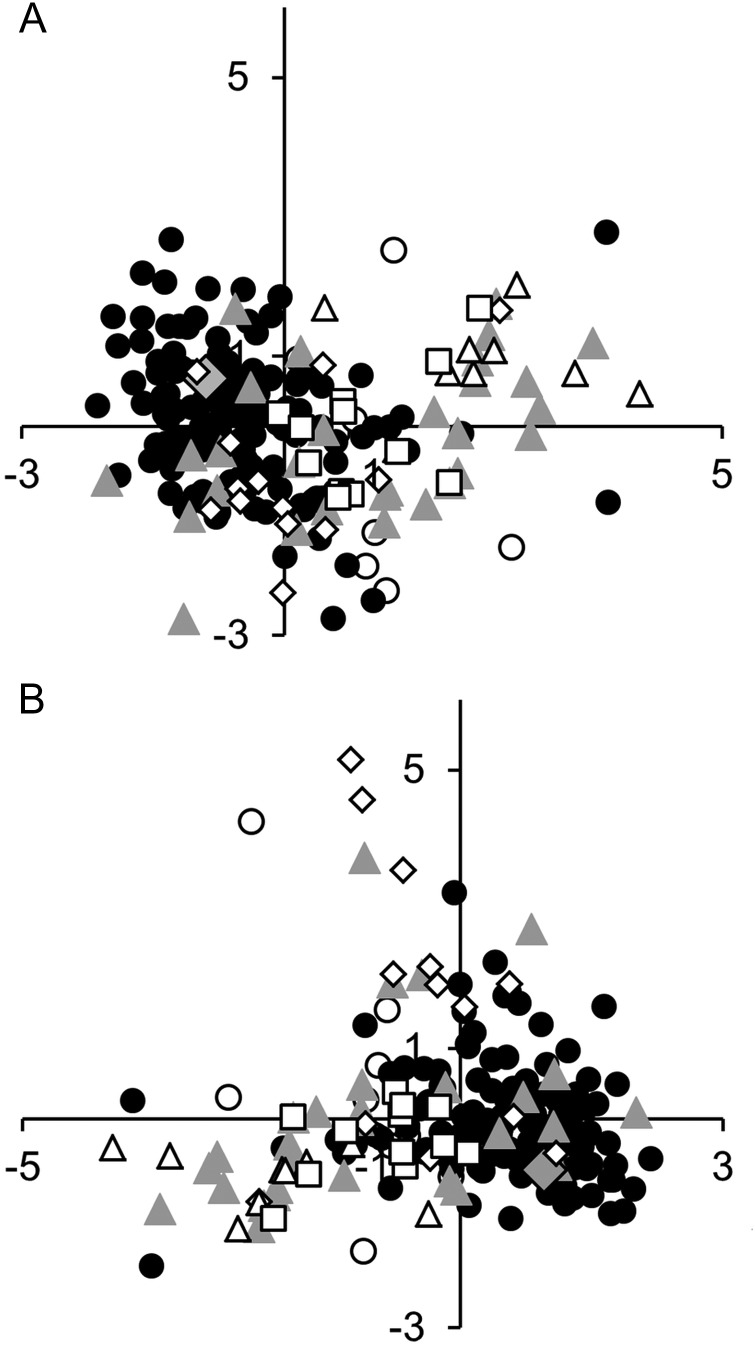
A. First two axes of a discriminant analysis of seven clades within the Trochulus hispidus complex based on measurements. Symbols: white circles, clade 1; black circles, clade 2; grey triangles, clade 3; grey rhombs, clade 5; white rhombs, clade 6; white triangles, clade 8; white squares, clade 9. LD1 on horizontal axis, LD2 on vertical axis. Coefficients of linear discriminants (LD1, LD2): shell width: −4.18, 41.54; width of umbilicus: −7.48, −10.22; shell height: 14.85, −23.39; height of last whorl: −2.06, −17.71. B. First two axes of a combined discriminant analysis of seven clades within the T. hispidus complex based on shell measurements and the first three dimensions of a correspondence analysis of qualitative shell traits. Symbols and axes as in A. Coefficients of linear discriminants (LD1, LD2): dimension 1: 0.19, −0.65; dimension 2: 0.06, 0.13; dimension 3: 0.27, −0.79; shell width: 5.74, −20.69; width of umbilicus: 7.03, 5.84; shell height: −16.06, 13.78; height of last whorl: 1.65, 6.11.